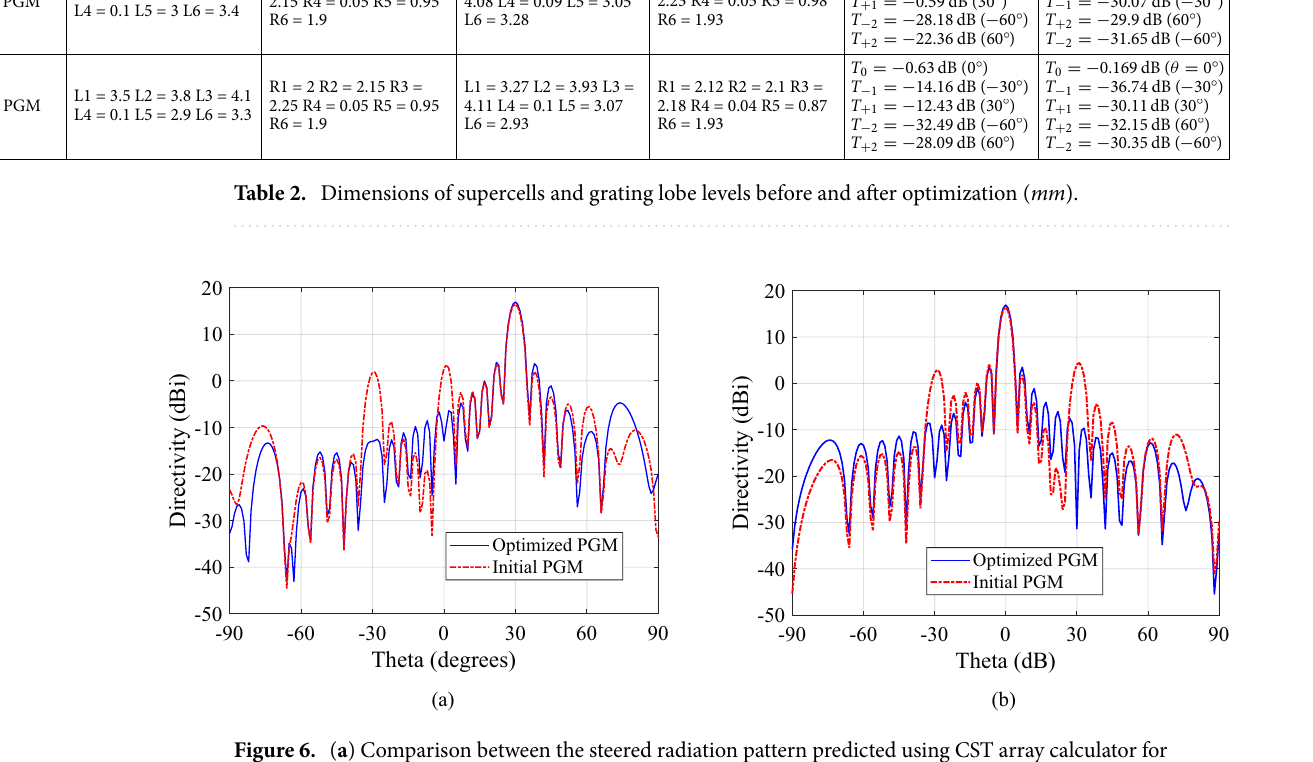
Figure 6. ( a ) Comparison between the steered radiation pattern predicted using CST array calculator for 12 (cid:31) 0 12 (cid:31) 0 aperture of optimized lower PGM and initial lower PGM when excited with a normally incident × plane wave and ( b ) optimized upper PGM and initial upper PGM when excited with an oblique incidence 30 180 ( θ in ◦ and φ in = ◦ =